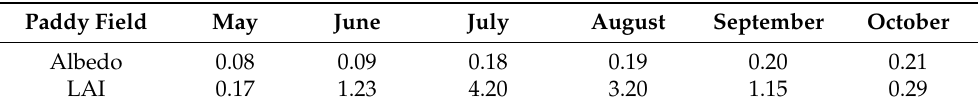
Figure 2. The land cover pattern for domain 1 (D01) and domain 2 (D02) in our experiments. Table 1. The regional monthly mean albedo and LAI for paddy fields. (When the saline-alkali land was converted to the paddy field, the albedo and LAI of the saline-alkali land were replaced by the corresponding values shown in this